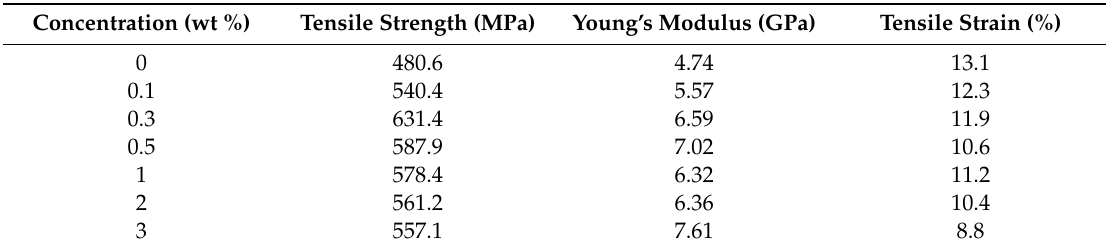
Table 1. Mechanical properties of polyvinyl alcohol (PVA)-only and PVA / edge-selectively oxidized graphene composite fibers, after hot-drawing.